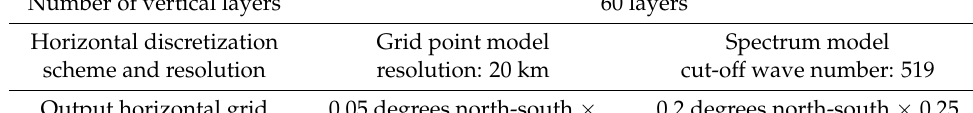
Table 1. Summary of numerical weather prediction data used in this study.